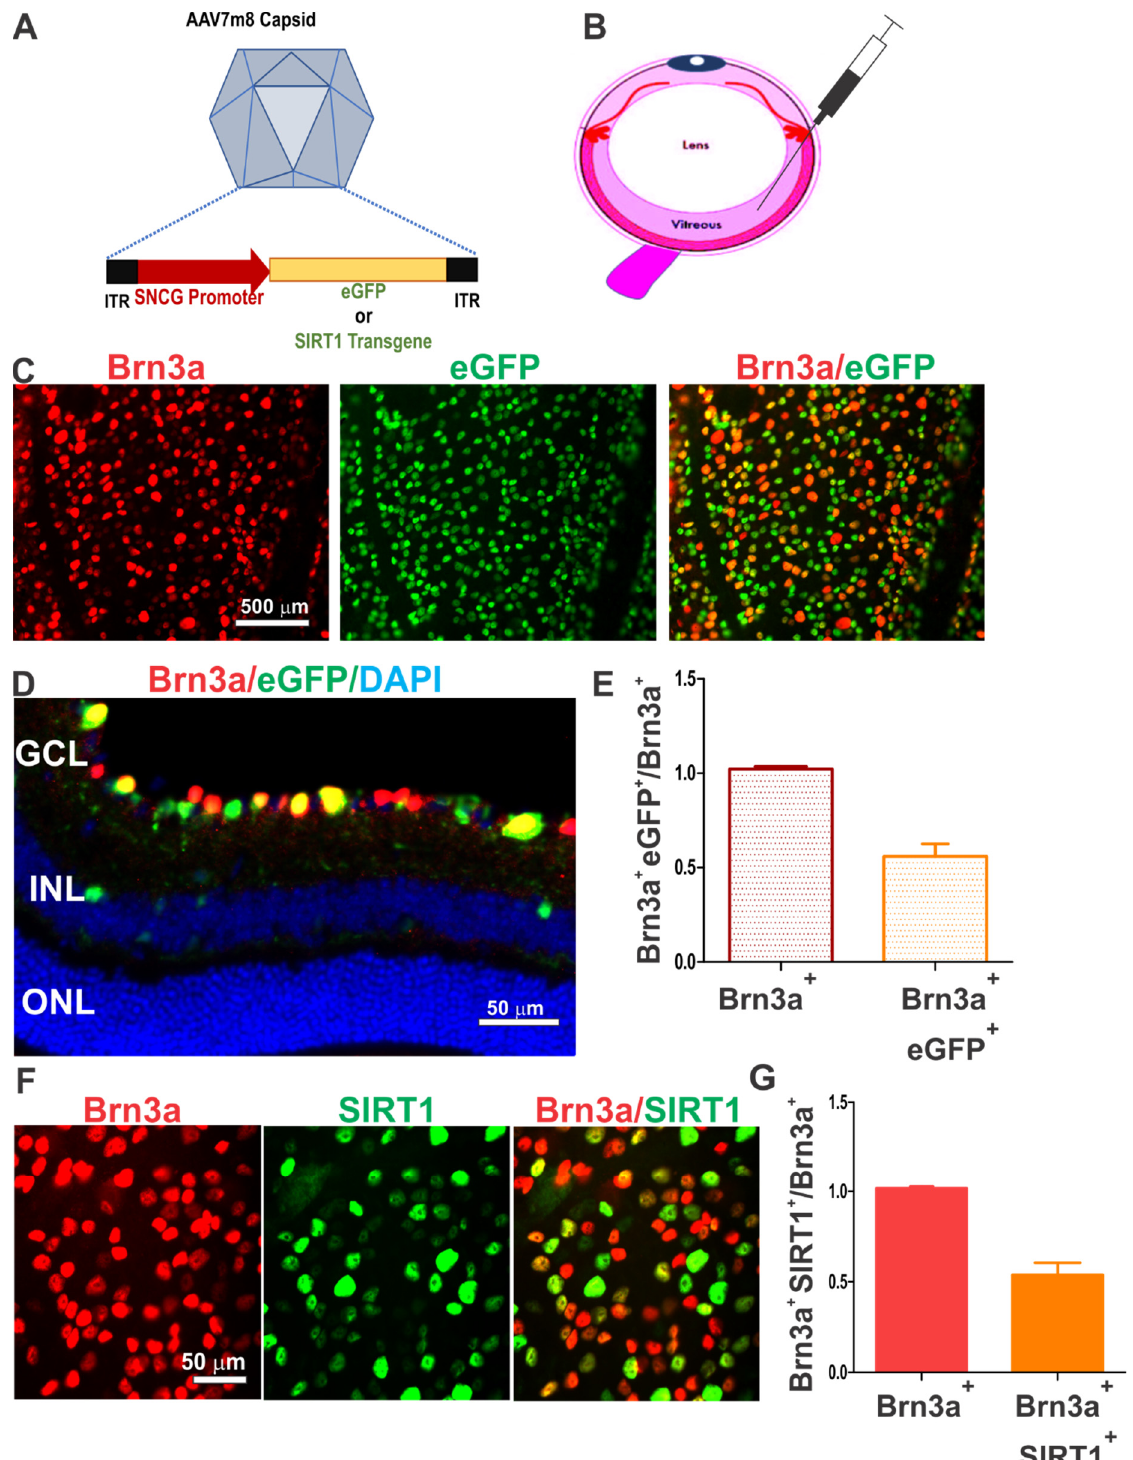
Figure 1. AAV7m8 transduced RGCs with high efficiency after single intravitreal injection. ( A ) Schematic representation of the AAV7m8 capsid and genome structure for enhanced transduction and RGC selective targeting. AAV7m8 was modified to drive the expression of the transgene (e.g., eGFP, SIRT1) under the control of the SNCG promoter. Transgene is placed between 2 internal terminal repeats (ITRs). ( B ) AAV7m8 administration is achieved through single injection of the AAV vector into the vitreous humor of the mouse eye. ( C ) Fluorescence micrographs of flat mounted preparation of mouse retina after intravitreal injection of the AAV7m8.SNCG.eGFP vector. RGCs were labeled with a monoclonal antibody against Brn3a. Merged eGFP (green) and Brn3a (red) signal is